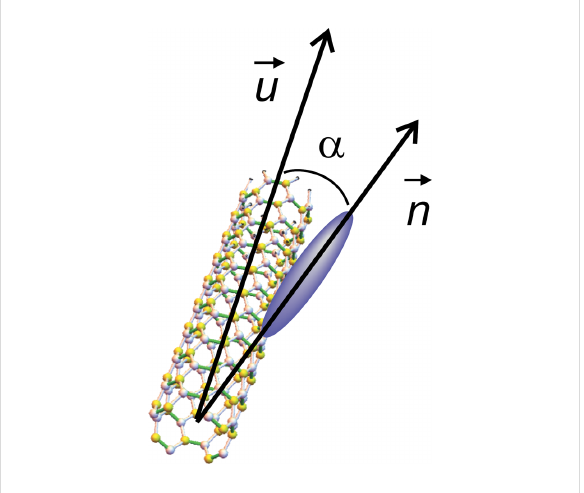
Figure 3: Orientation of a liquid crystal molecule on a CNT